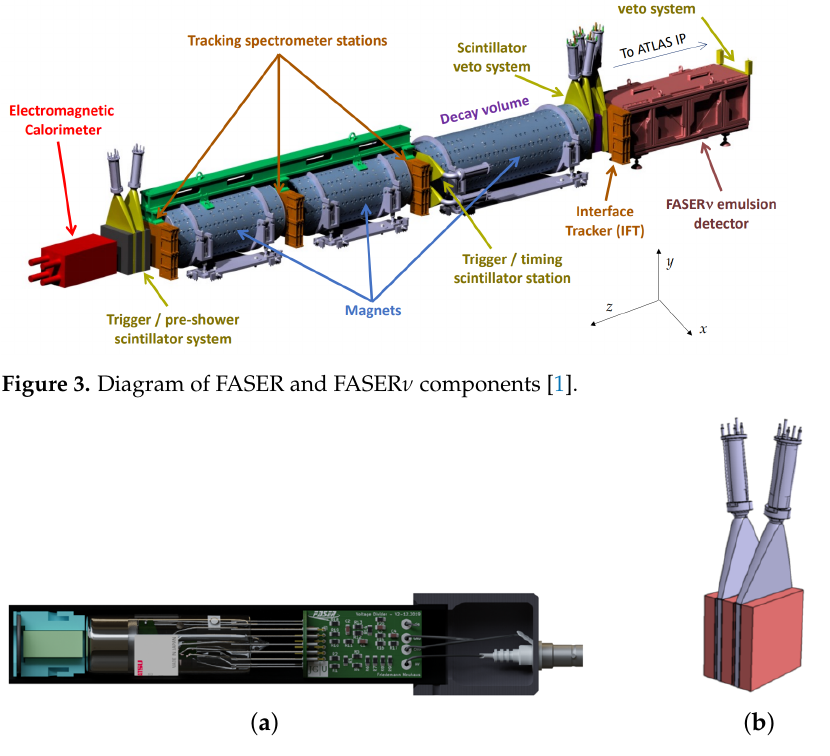
Figure 4. ( a ) A diagram of a PMT module that provides readout pulses to the pre-shower station and calorimeter modules. ( b ) A sketch of the pre-shower station showing the two scintillators (grey), each preceded by 3 mm of tungsten and 5 cm of graphite (red).